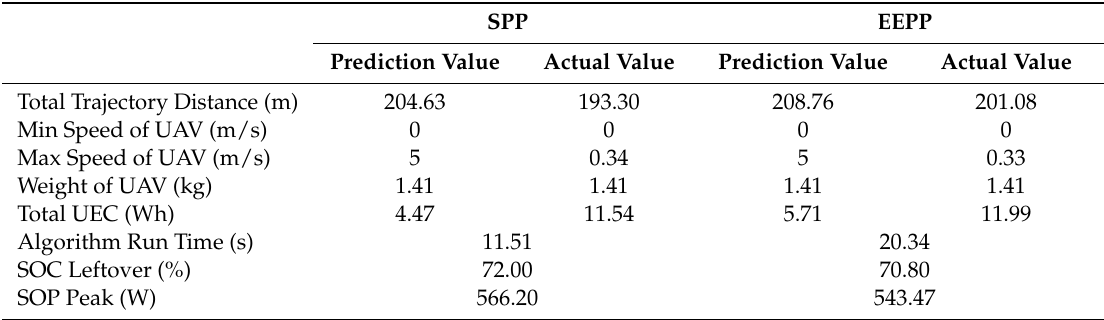
Table 2. Comparison result (simulation).